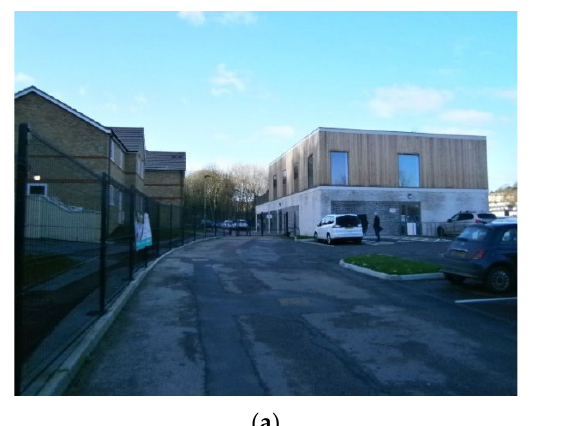
Figure 5. New Harmonia Village under CASCADE project and near surroundings, Dover, United Kingdom. Source: Own elaboration.